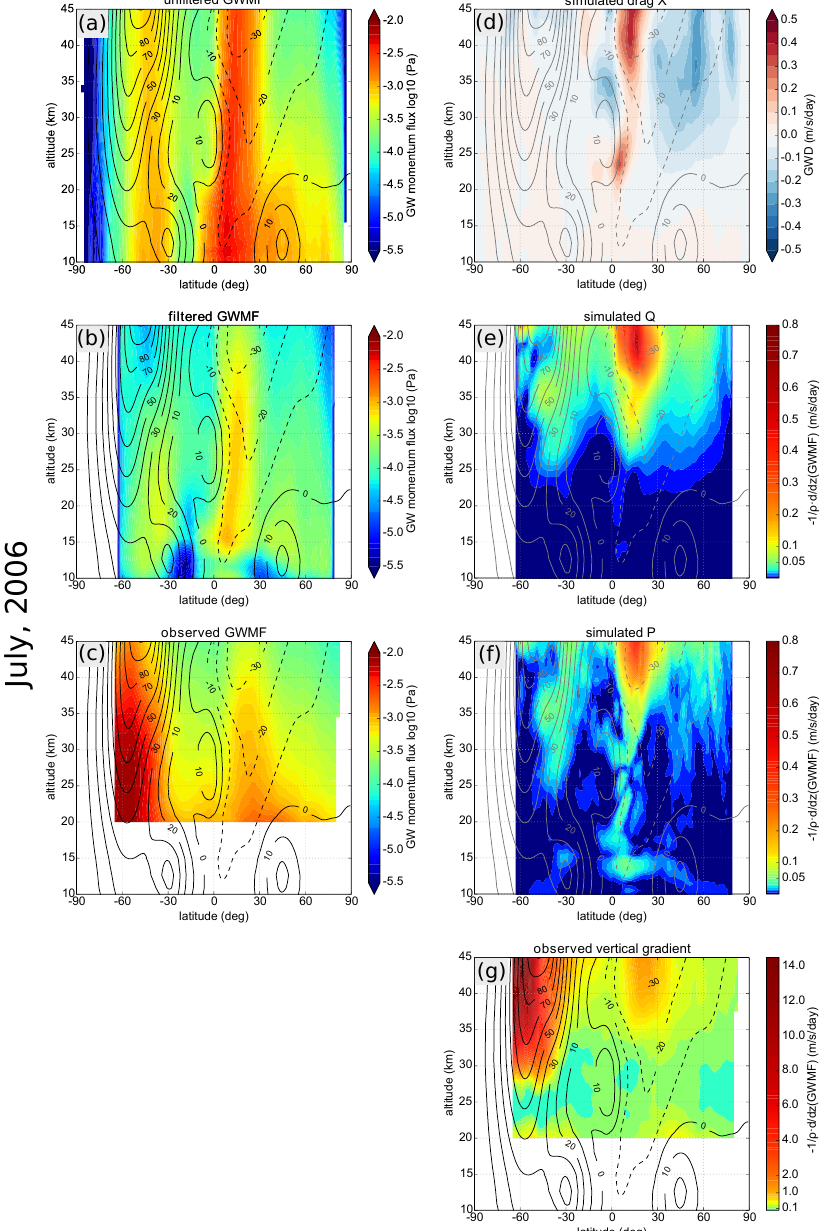
Figure 5. Comparison of simulated GWMF and its vertical gradients with observations from HIRDLS for July 2006. Panel (a) shows simulated unfiltered absolute GWMF. Panel (b) shows simulated filtered absolute GWMF. Panel (c) shows absolute GWMF observed by HIRDLS. Panel (d) shows simulated zonal GW drag. Panel (e) shows simulated vertical gradient Q . Panel (f) shows simulated vertical gradient P . Panel (g) shows observed vertical gradient of absolute GWMF from HIRDLS. Simulations were performed using MERRA data. For details see